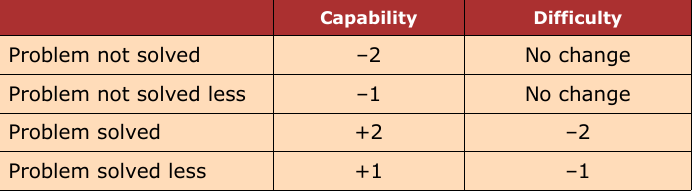
Table 1. Rules for Capability and